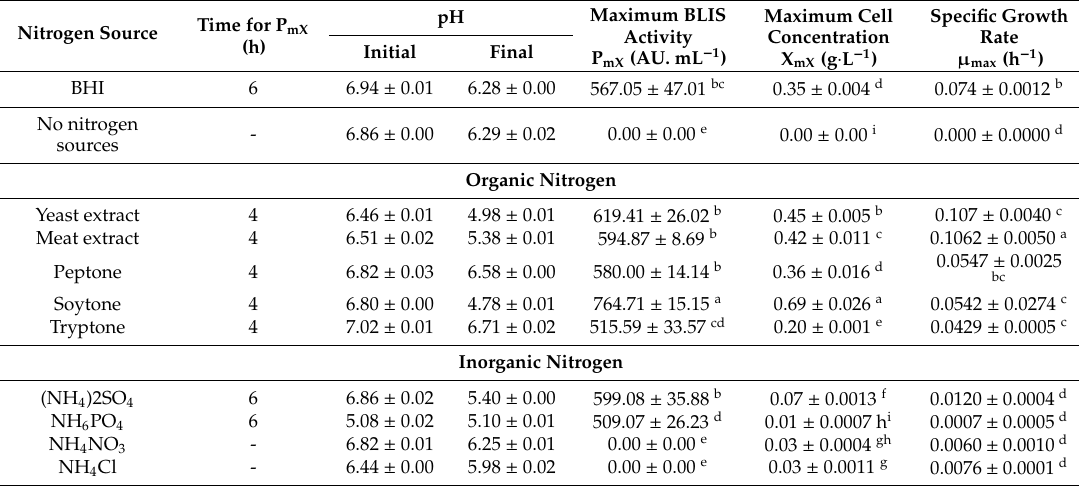
Table 7. Growth of L. lactis Gh1 and BLIS production by using modified BHI medium supplemented with di ff erent organic nitrogen (N) sources. All nitrogen sources were added at concentration of 4.6 g / L N.